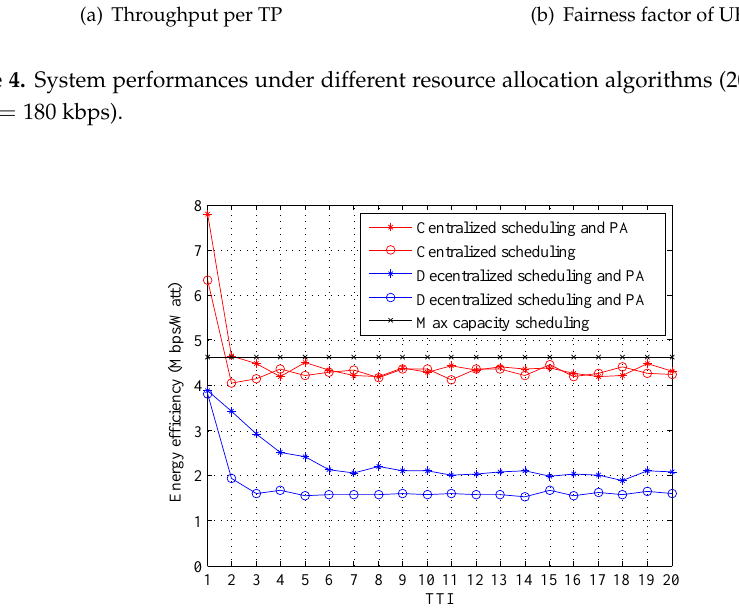
Figure 5. Energy efficiencies under different resource allocation algorithms (20 Watts, infinite C m , R thres = 180